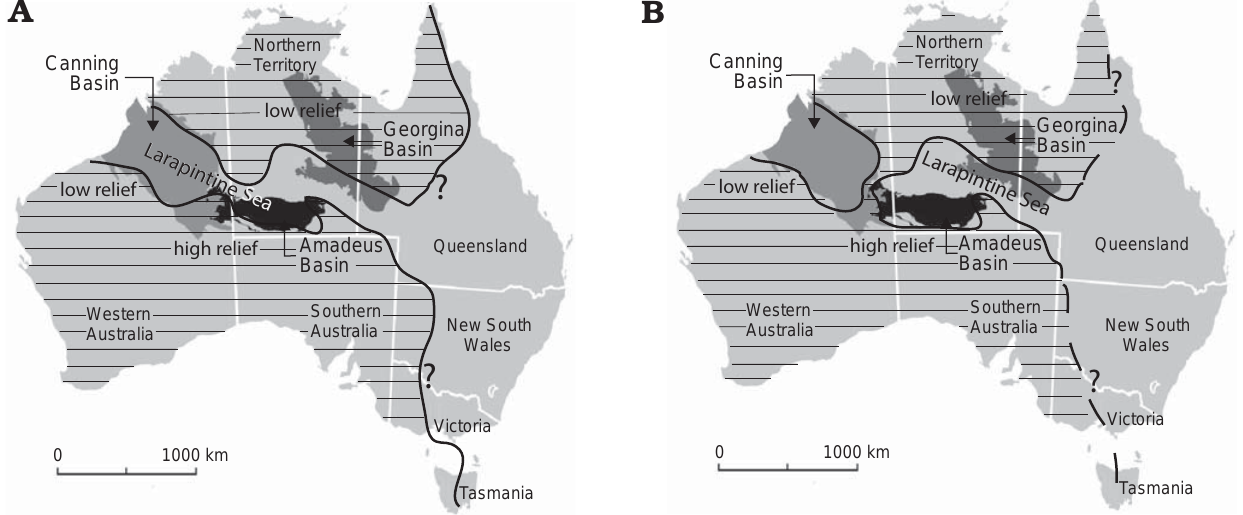
Fig. 2. Distribution of the Larapintine Sea in the Middle Ordovician. The extent of the Canning, Amadeus, and Georgina basins, all containing Middle Ordovician deposits, have been inferred together with the extent of continental landmass (marked with horizontal lines). Base map modified from Webby 1978. A . Webby’s interpretation (1978). B . New interpretation based on faunal correlation. Note the broken connection between the Amadeus–Georgina basins and the Canning